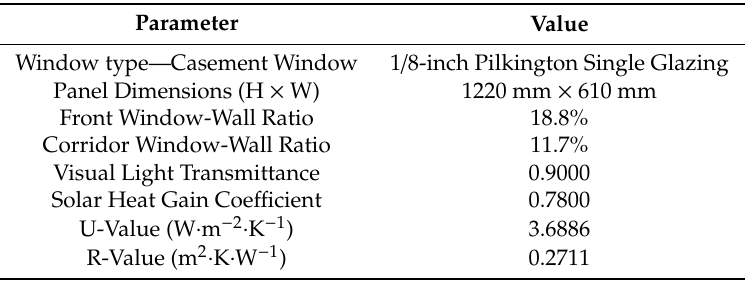
Table 3. Window Analytic